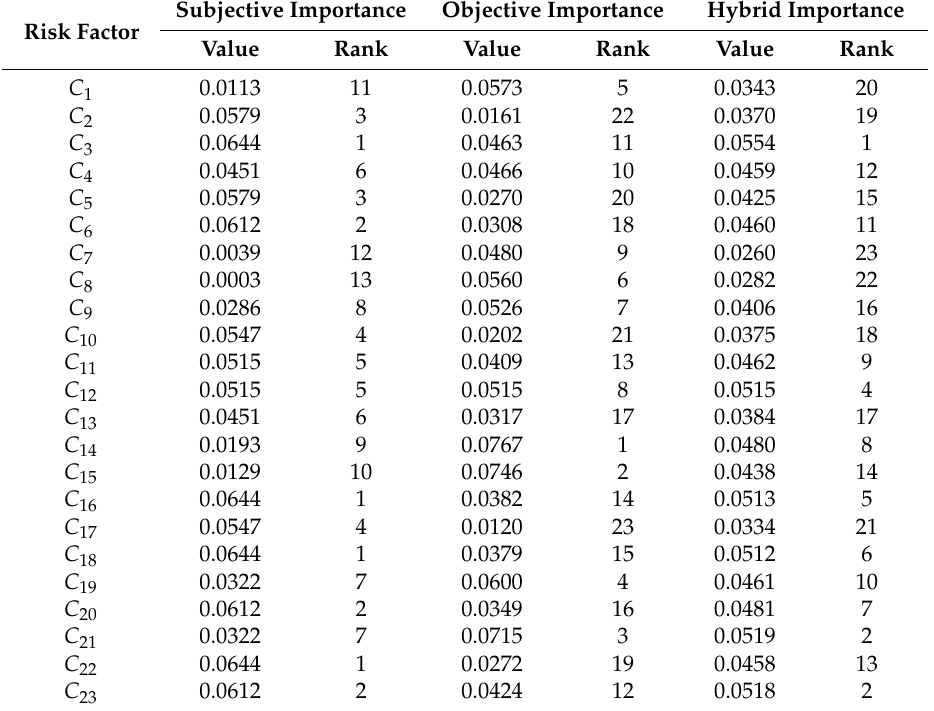
Table 9. Subjective, objective, and hybrid risk factor